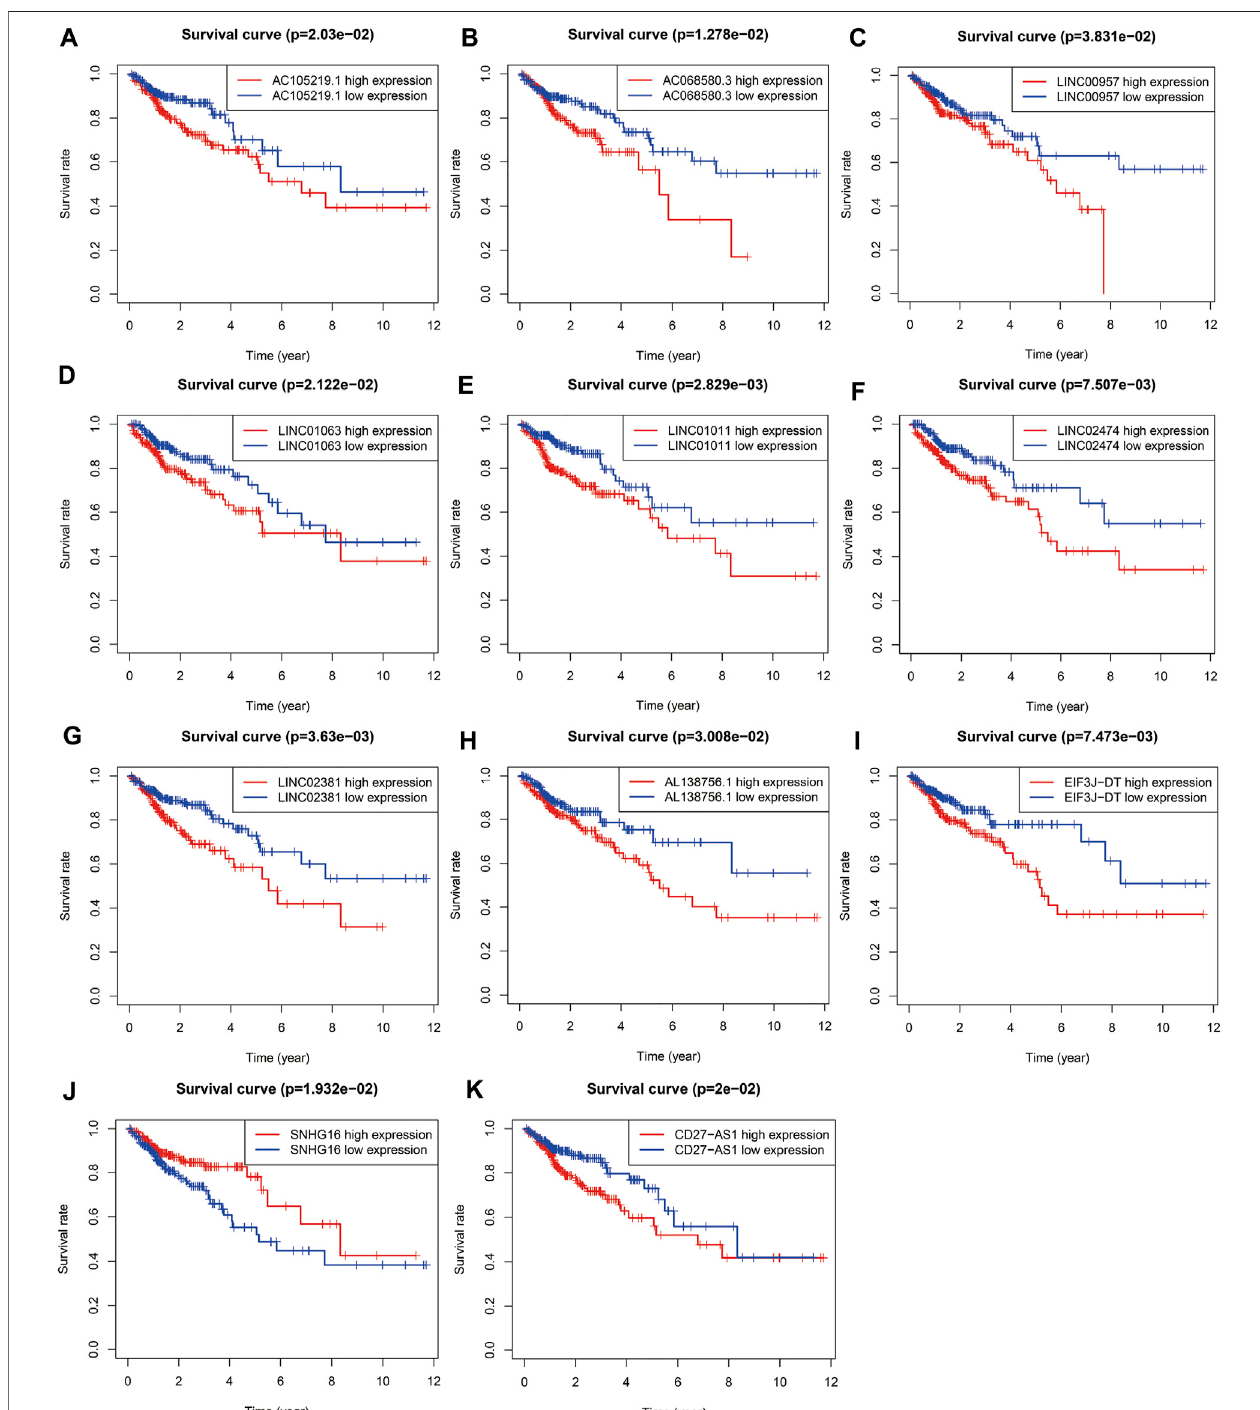
FIGURE 3 | Survival curve of each autophagy related lncRNAs. Kaplan-Meier survival curves of 11 autophagy related lncRNAs were selected with p < 0.05 as the screening criteria. The red plots represent the high expression and the blue plots represent the median/low expression.